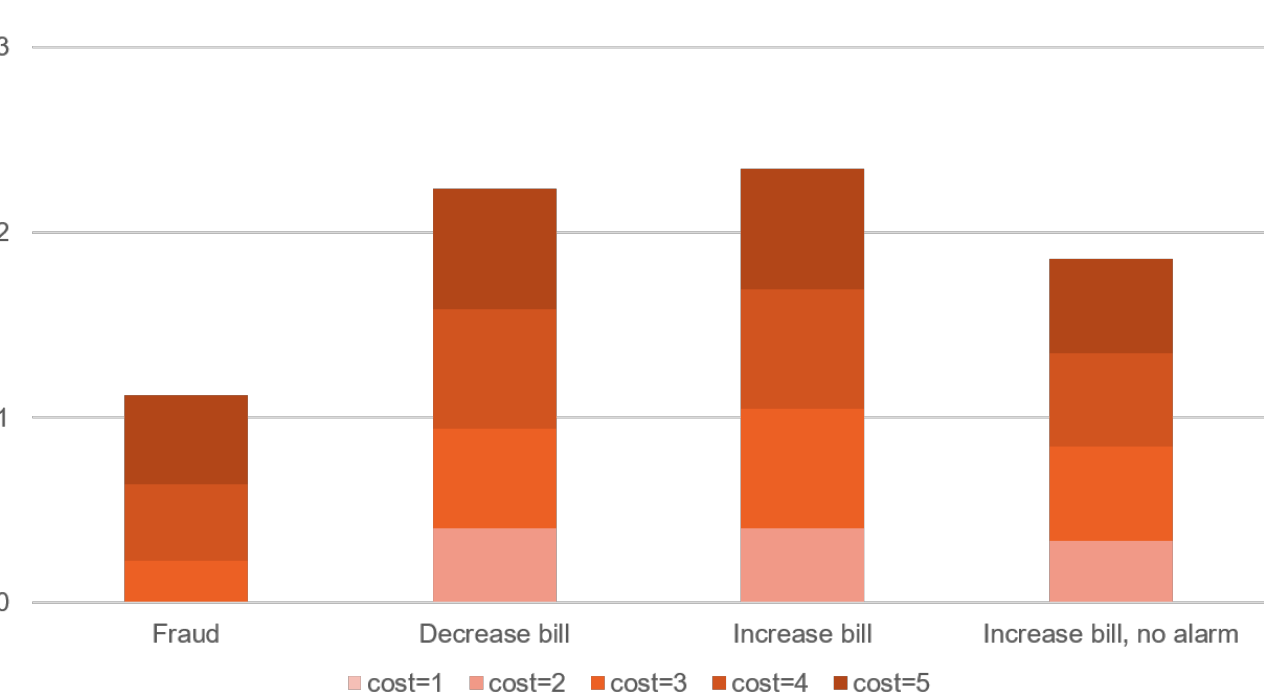
Figure 10. Smart home and smart meter hijacking use case